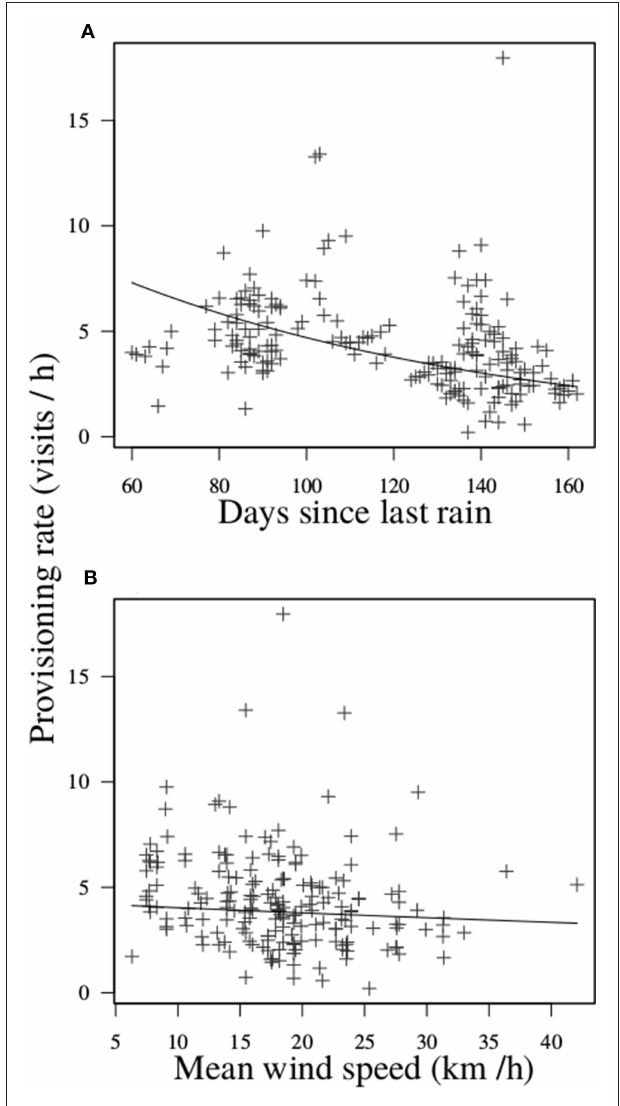
FIGURE 1 | Daily provisioning rate of dominant males as a function of: (A) days since last meaningful rain; and (B) mean daily wind speed (km/h). Lines show predicted